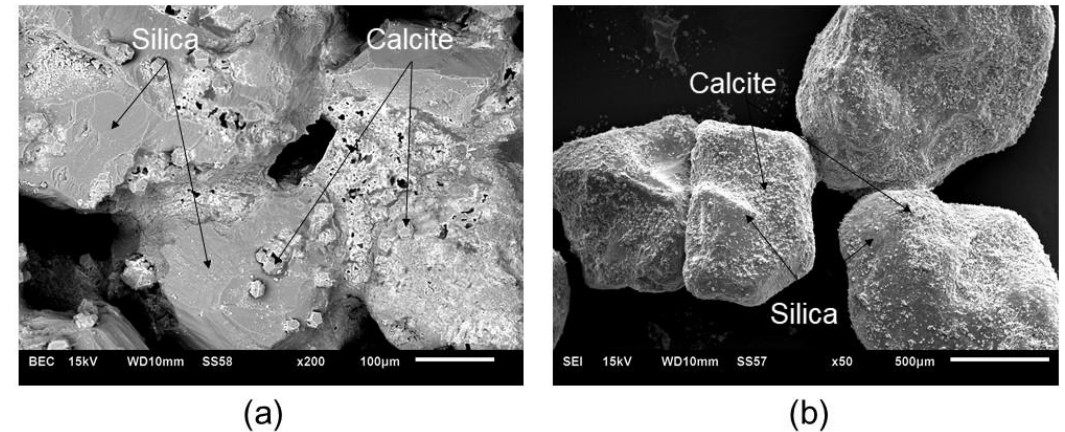
Figure 9. SEM images of precipitated material in treated sand: ( a ) at free surface and boundary of sand grains [28] and ( b ) on surface of sand grains [26].